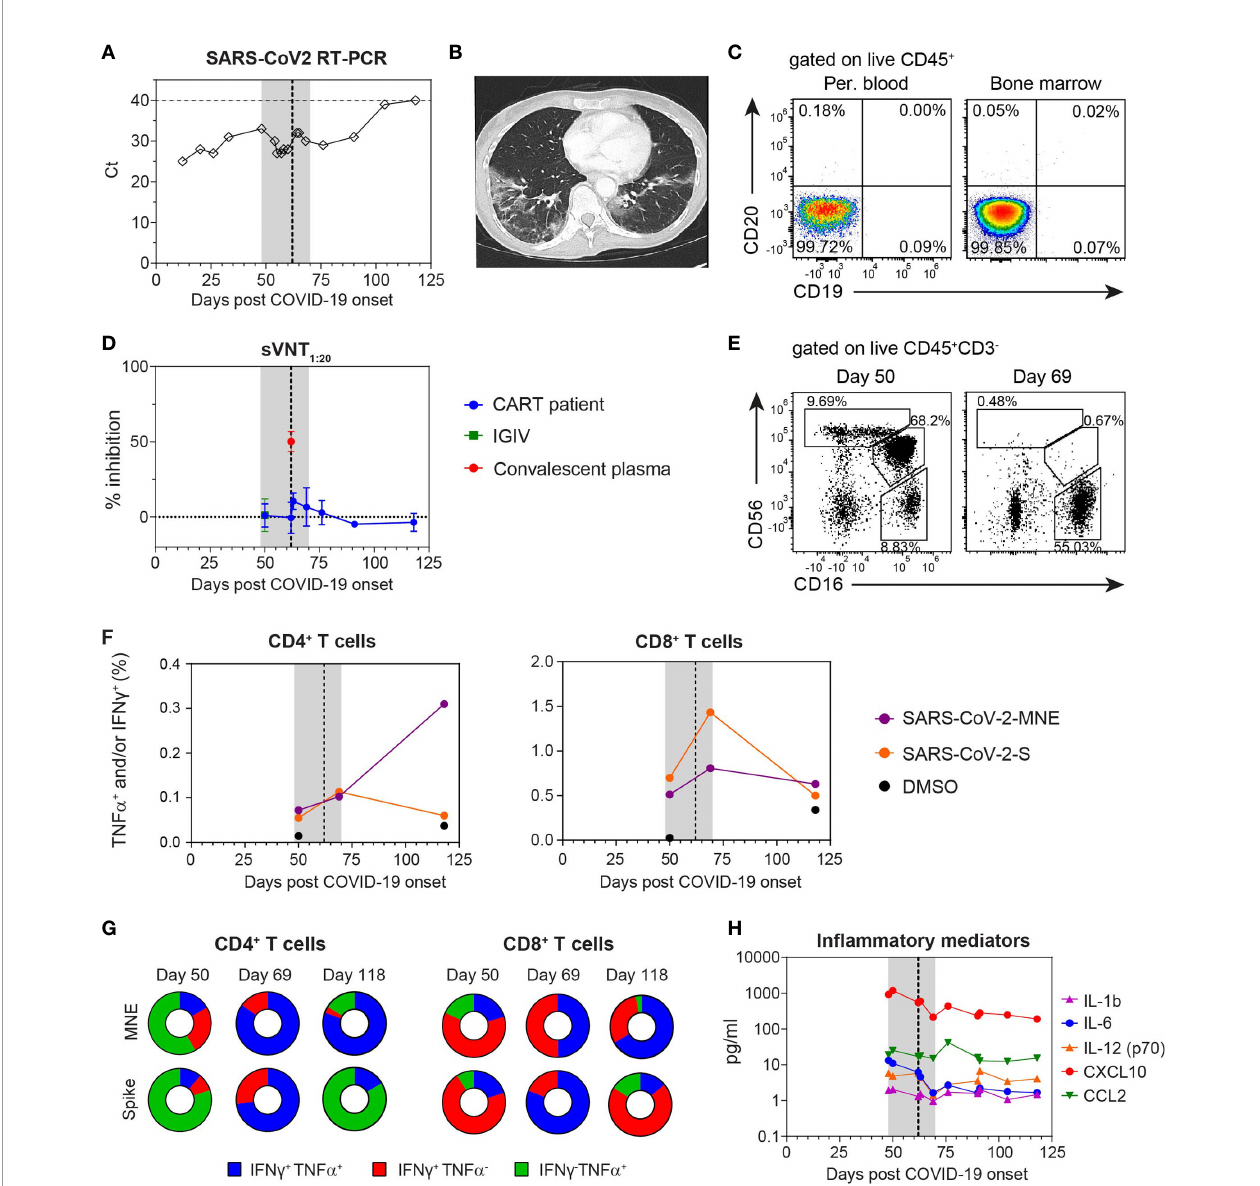
FIGURE 1 | Protracted COVID-19 in a patient after CD19 CART resolved after CP therapy that coincided with increase in anti-SARS-CoV2 T cell-mediated response. (A) SARS-CoV-2 Ct values measured with RT-PCR. (B) Lung CT scan at day 51 post infection showing typical pattern of COVID-19 disease. (C) Complete B cell-de fi ciency in peripheral blood and bone marrow analyzed 10 months after CAR-T cell treatment shown by fl ow cytometry. (D) Neutralizing anti- SARS-CoV-2 antibody levels measured as inhibition of anti-SARS-CoV2 S-RBD with hACE2 at 1:20 plasma dilution by sVNT. (E) Blood NK cell show a CD16 + CD56 - phenotype following CP therapy. (F) Total percentage of interferon gamma (IFN- g ) and/or tumor-necrosis factor alpha (TNF- a ) producing CD8 + and CD4 + T cells following ex vivo stimulation with pooled spike (S)- or membrane, nucleocapsid, and envelope (MNE) peptide pools, gated as shown in Supplementary Figure 1 . (G) Relative distribution of CD8 + and CD4 + T cells producing IFN- g and/or TNF- a at time-points indicated. (H) Concentration of 5 selected of 27 measured in fl ammatory mediators in plasma. Depicted mediators have either markedly changed their concentrations post CP treatment. The concentrations of all tested cytokines are listed in Supplementary Table 1 . (A, D, F, H) Shaded area indicates hospitalization; vertical dashed line indicates treatment with